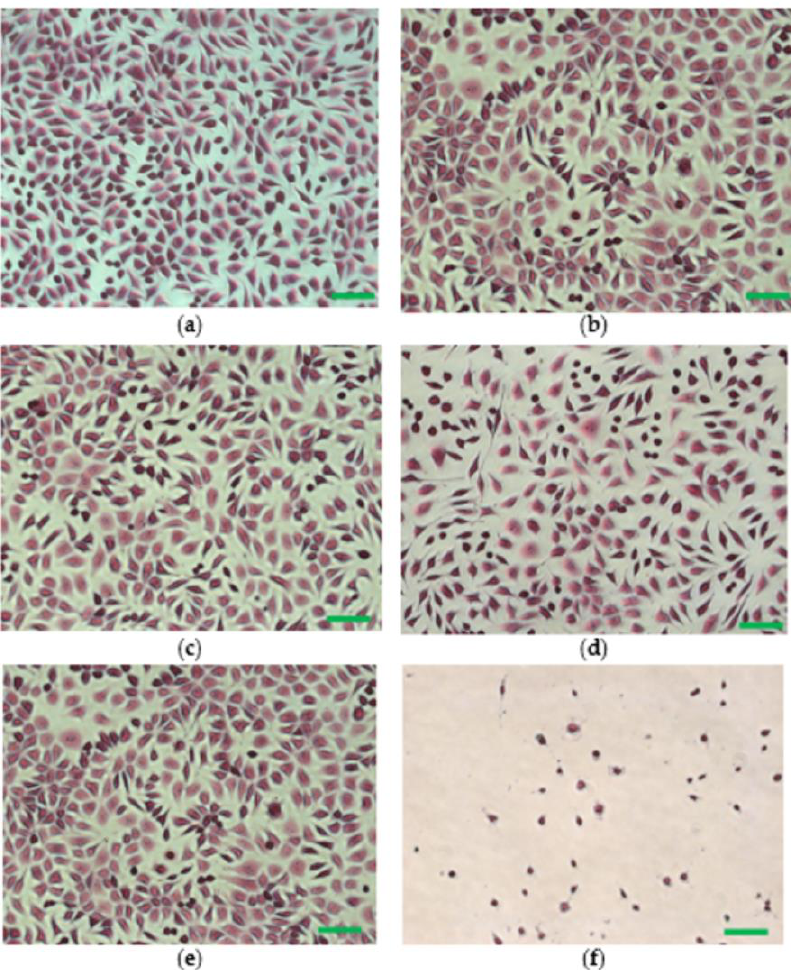
Figure 6. Cell morphology after 48 h treatment with different biocomposites: neat PHBV ( a ); PHBV/Vitamin E ( b ); PHBV/BC1% ( c ); PHBV/BC2% ( d ). Negative control was represented by